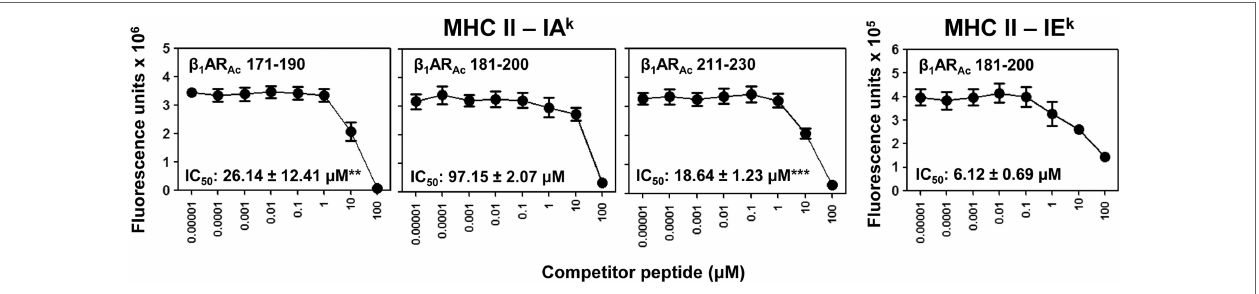
FigUre 3 | Determination of major histocompatibility complex (MHC) class II-binding affinities of β 1 AR Ac peptides. Mixtures containing thrombin-cleaved IA k and IE k soluble monomers (0.35 µg), competitor peptides— β 1 AR Ac 171–190, β 1 AR Ac 181–200, and β 1 AR Ac 211–230 (0.00001–100 µM)—and biotinylated hen egg lysozyme (HEL) 46–61 (reference for IA k ) and moth cytochrome c (MCC) 82–103 (reference for IE k ) (1 µM) were prepared and added to fluorescence plates coated with anti-IA k or IE k in duplicates as described in the methods. After washing, and addition of europium-labeled streptavidin (SA) and dissociation-enhanced lanthanide fluoroimmunoassay (DELFIA) enhancer, fluorescence intensities were measured at excitation/emission wavelengths of 340/615 nm to calculate the IC 50 values. Mean ± SEM values from three individual experiments with two replicates in each are shown. ** P < 0.01 and *** P < 0.001 vs. IC 50 of IA k / β 1 AR Ac